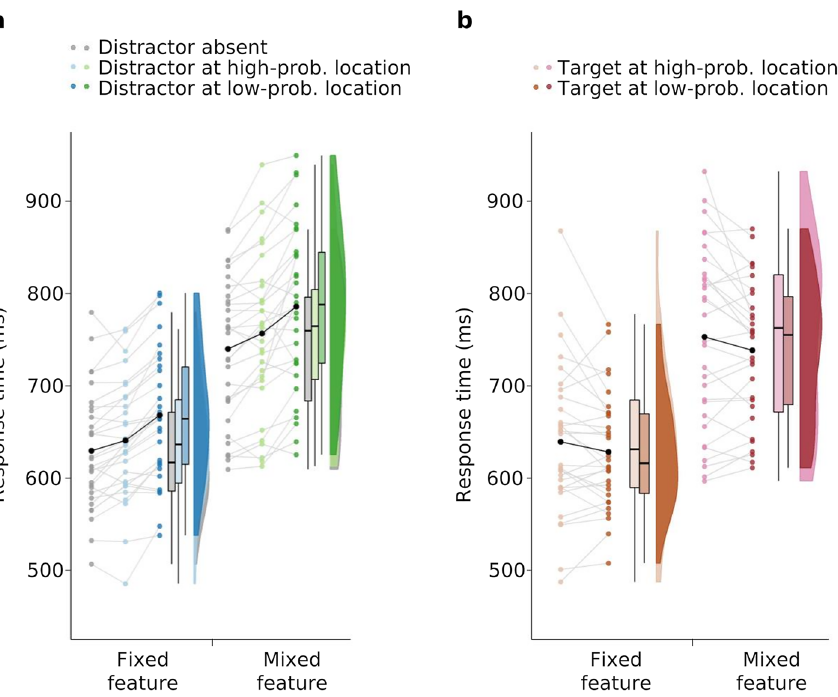
Figure 2. Search response times for fixed-feature targets (left side of the panels) and mixed-feature targets (right side of the panels). ( a ) Box-whisker plots show mean response times as a function of distractor-absent trials (grey), and distractor-present trials (coloured), with the distractor presented at the high-probability location (light blue and green) and at the low-probability locations (dark blue and green). ( b ) Box-whisker plots show mean response times in distractor-absent trials (coloured), with the target presented at the high- probability distractor location (light orange and pink) and at the low-probability distractor locations (dark orange and pink). Coloured and grey dots show response times for individual participants. Mean response times are shown in